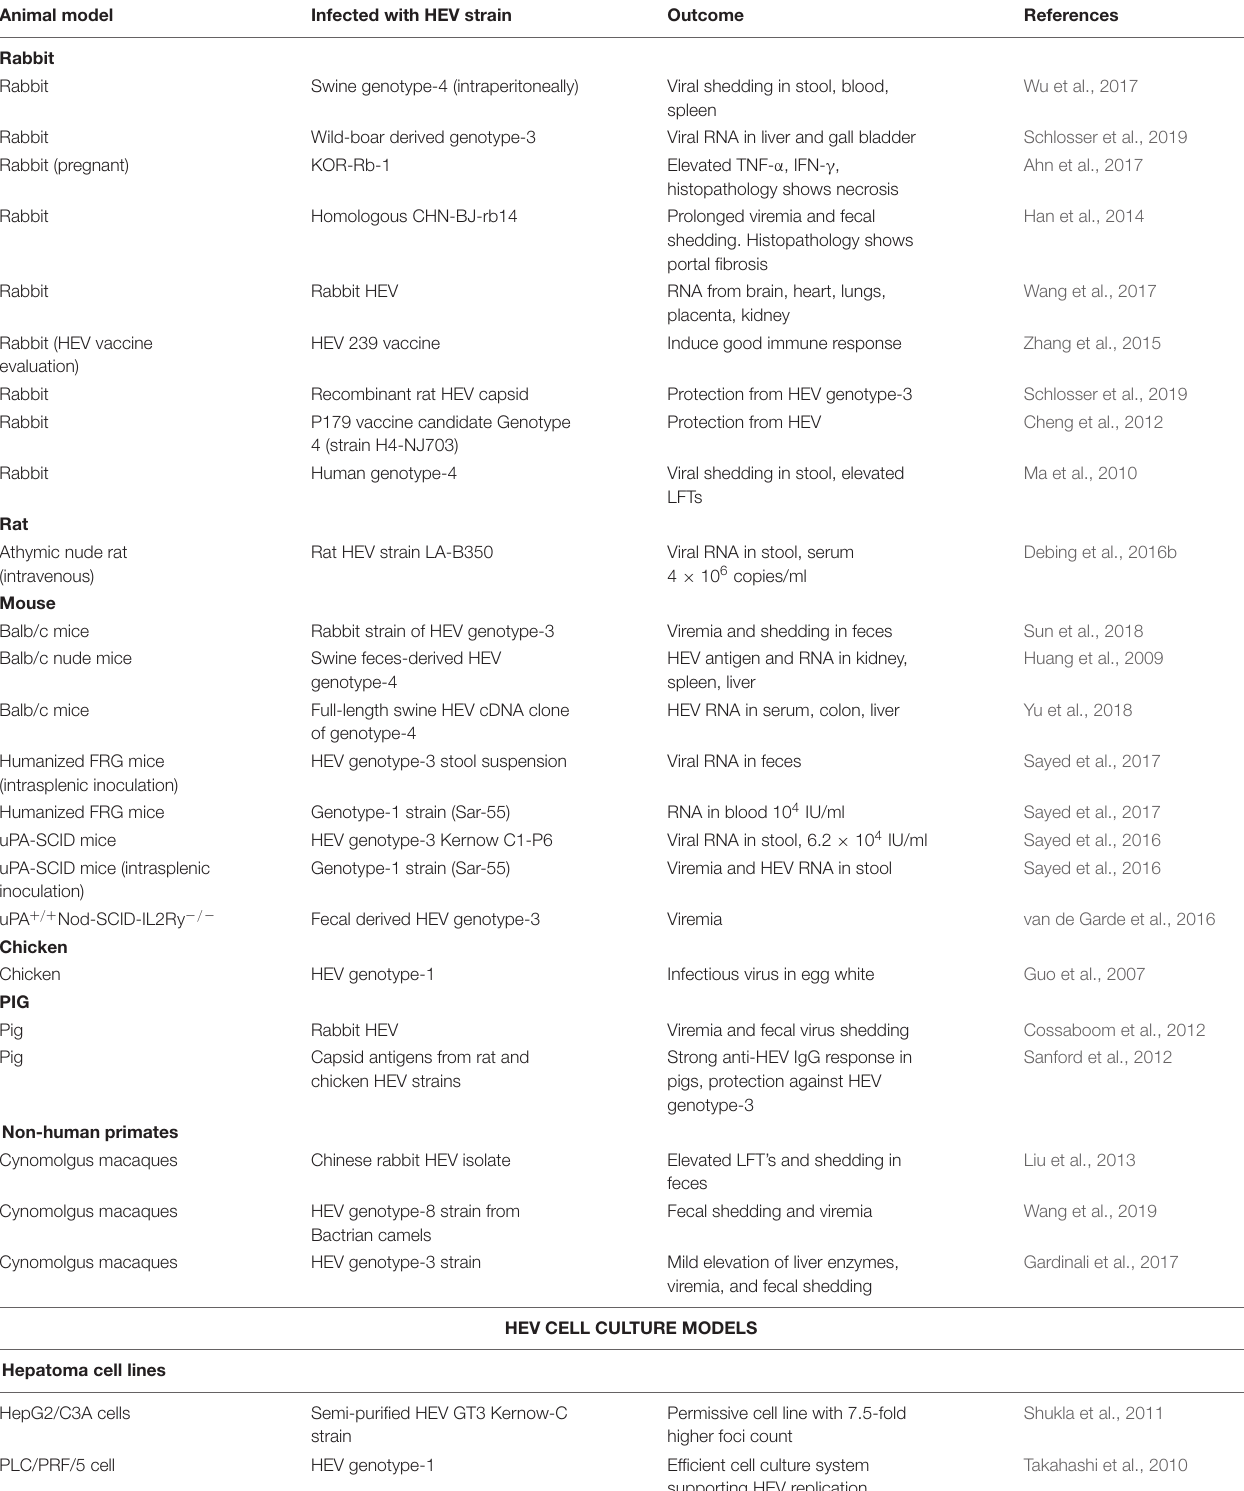
TABLE 2 | Animal and cell culture models used for the propagation of different genotypes of Hepatitis E virus. Animal